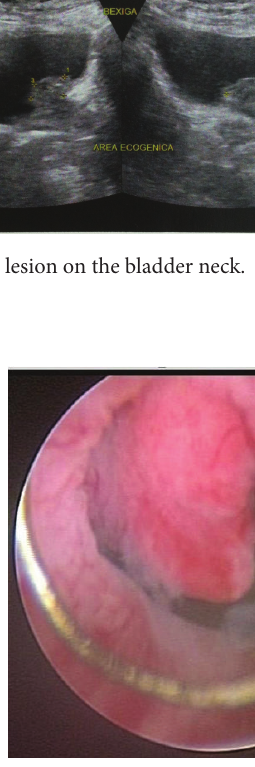
Figure 3: Preoperative image of the vesical lesion originating in the anterior aspect of the bladder neck, visible resection